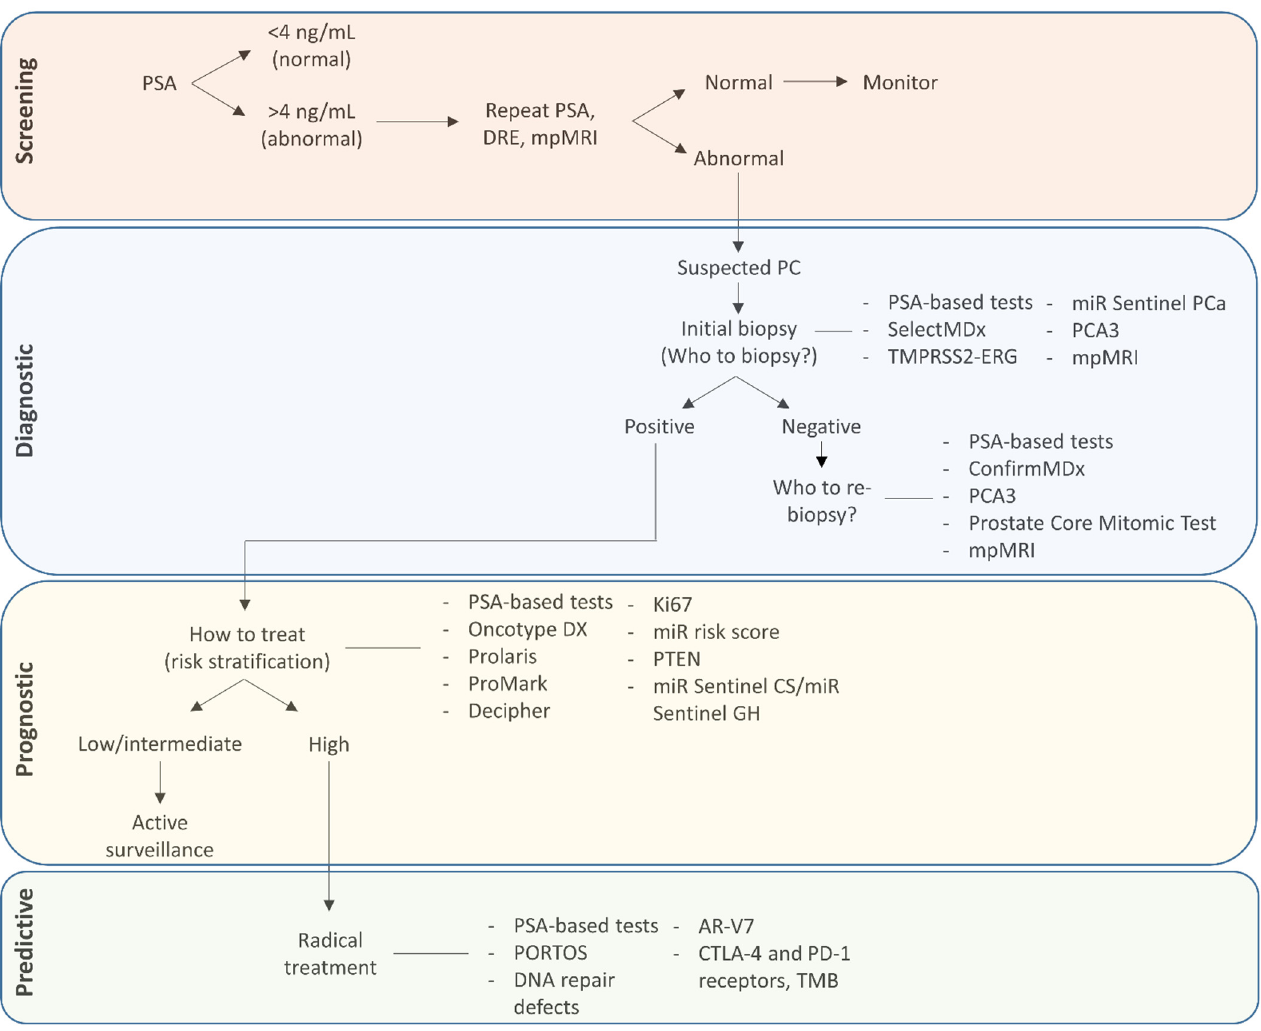
Figure 1. Biomarker assays and their use in PC management. AR-V7, androgen receptor splice variant 7; CTLA-4, cytotoxic T lymphocyte-associated protein-4; DRE, Digital rectal examination; mpMRI, multi-parametric magnetic resonance imaging; PC, Prostate cancer; PD-1, programmed death-1; PORTOS, Post-Operative Radiation Therapy Outcomes Score; PSA, Prostate specific antigen; PTEN, phosphatase and tensin homolog; TMB, Tumour mutational burden.